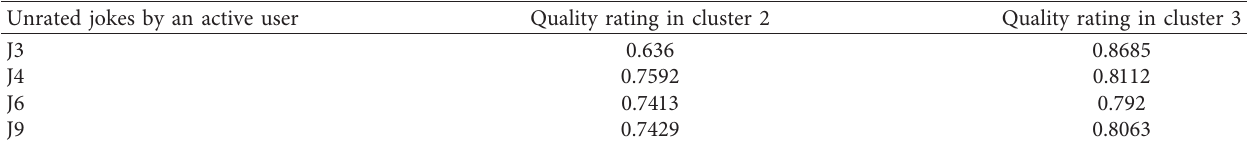
Table 6: Rating quality of unrated jokes in selected clusters.